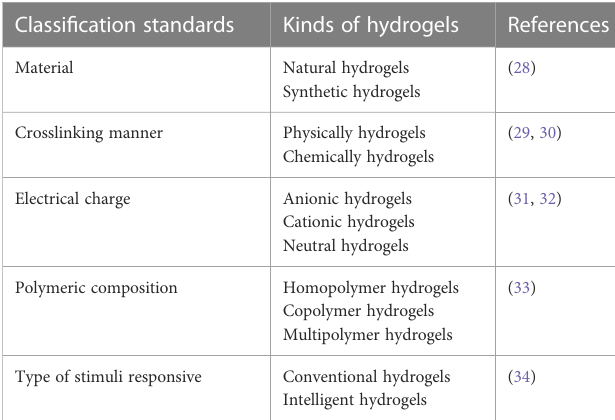
TABLE 1 The classi fi cation of hydrogels based on different